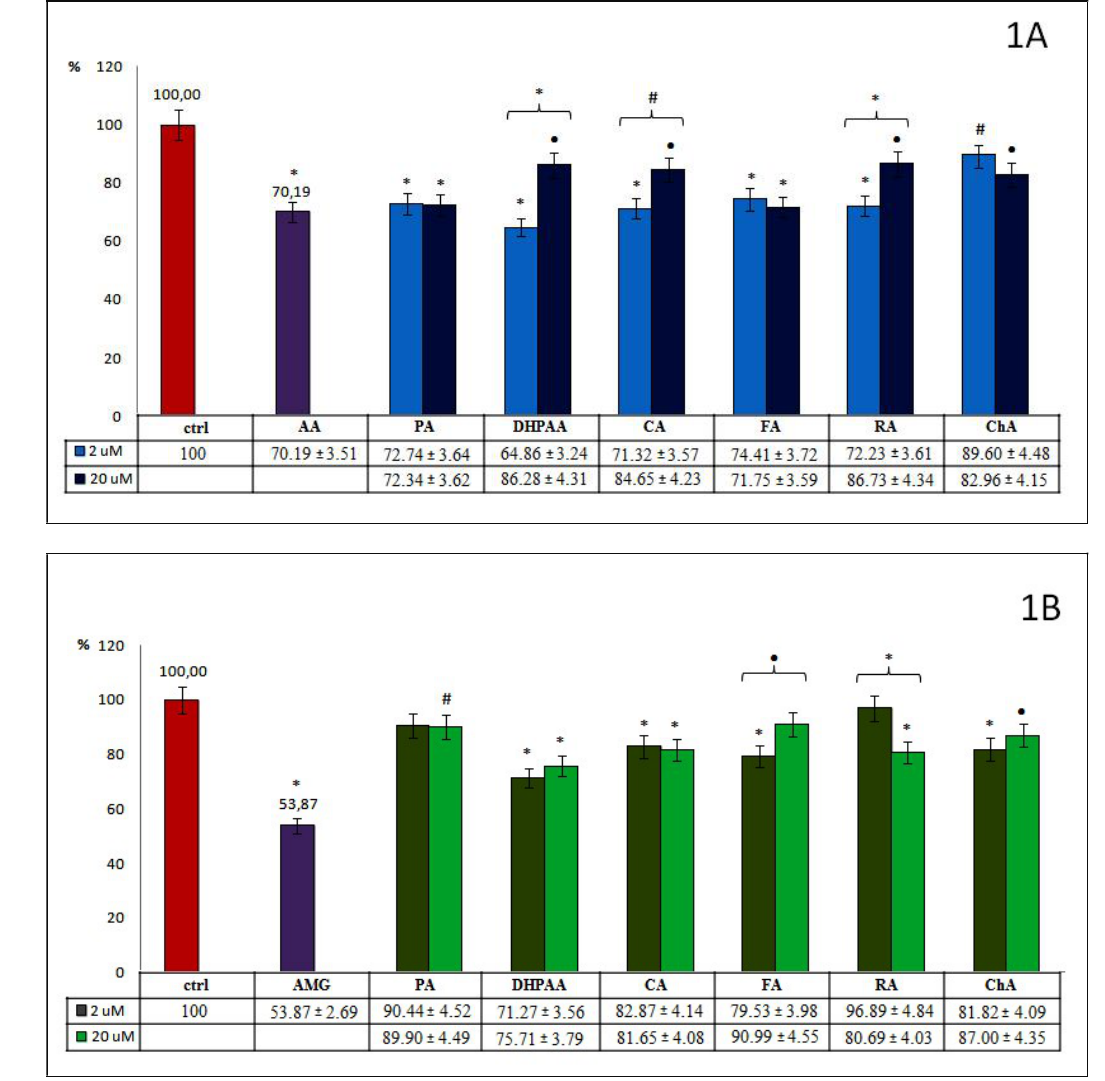
Figure 1. Percentage of advanced oxidation protein products (AOPPs) ( 1A ) and advanced glycation end products (AGEs) ( 1B ) formation during the glycoxidation process in samples incubated with 2 and 20 µM of tested phenolic acids and their esters (group 1.). Significant differences in comparison to (ctrl), as well as between both used concentrations, were expressed as: (*) p < 0.001, (•) p < 0.01, (#) p < 0.05.